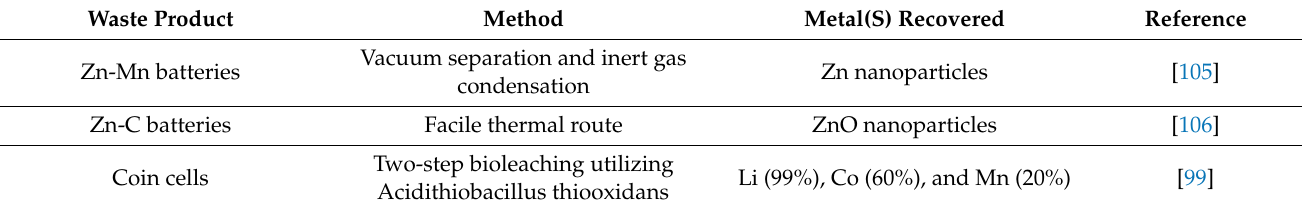
Table 9. A summary of work done in recycling batteries to metals and value-added materials. Waste Product